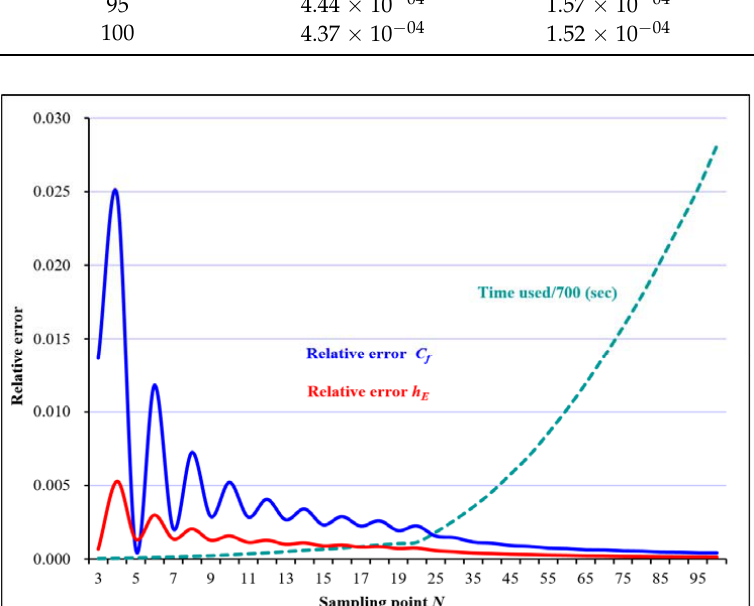
Figure 6. Error trends of the least squares curve ‐ fitting method with the number of sampling points.